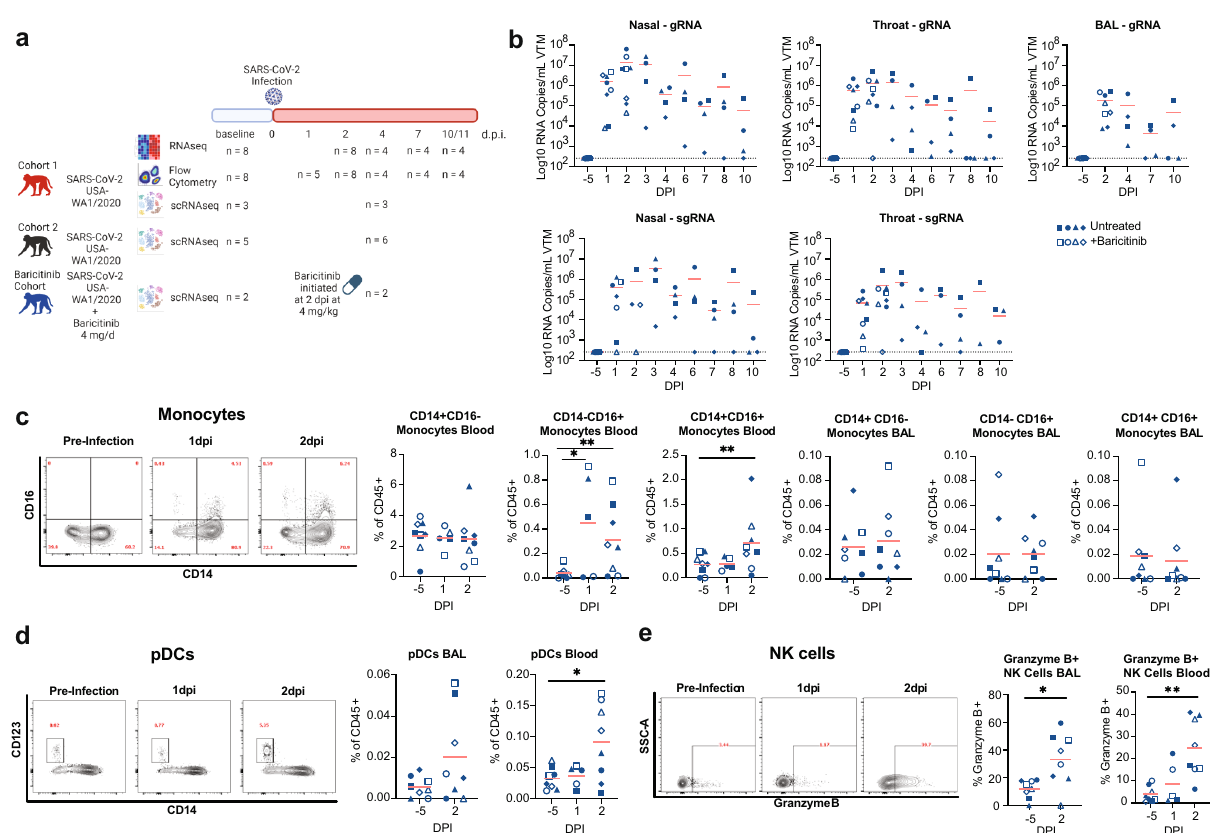
Fig. 1 | Early expansion of in fl ammatory cells in the blood following infection with SARS-CoV-2. a Study design; RMs were infected intranasally and intra- tracheally with SARS-CoV-2 and tracked longitudinally (Cohort 1: n =4, baricitnib cohort: n =4, Cohort 2: n =6). Baricitinib was administered daily to 4 RMs (bar- icitinib cohort)starting at 2dpi.The 4RMs from Cohort1 and 6 RMs from Cohort 2 were untreated. (Created with BioRender.com). b After SARS-CoV-2 inoculation, nasal, throat, and bronchoalveolar lavages (BAL) were collected and viral loads were quanti fi ed by qRT-PCR for total gRNA and sgRNA. c Longitudinal levels of monocytes within BAL and blood depicted as a % of CD45+ cells. p values: CD14 − CD16+MonocytesBlood:1dpivs. − 5dpi=0.03and2dpivs. − 5dpi=0.004;